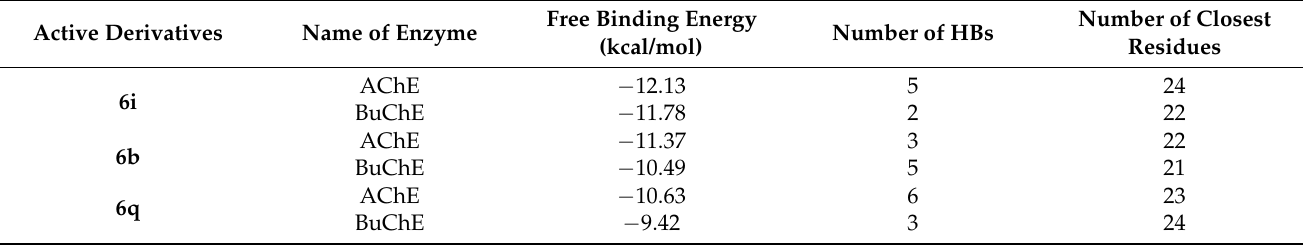
Table 2. Binding energies, number of hydrogen bonding and the number of closest residues of the selected docked analogues into the active site of both AchE and